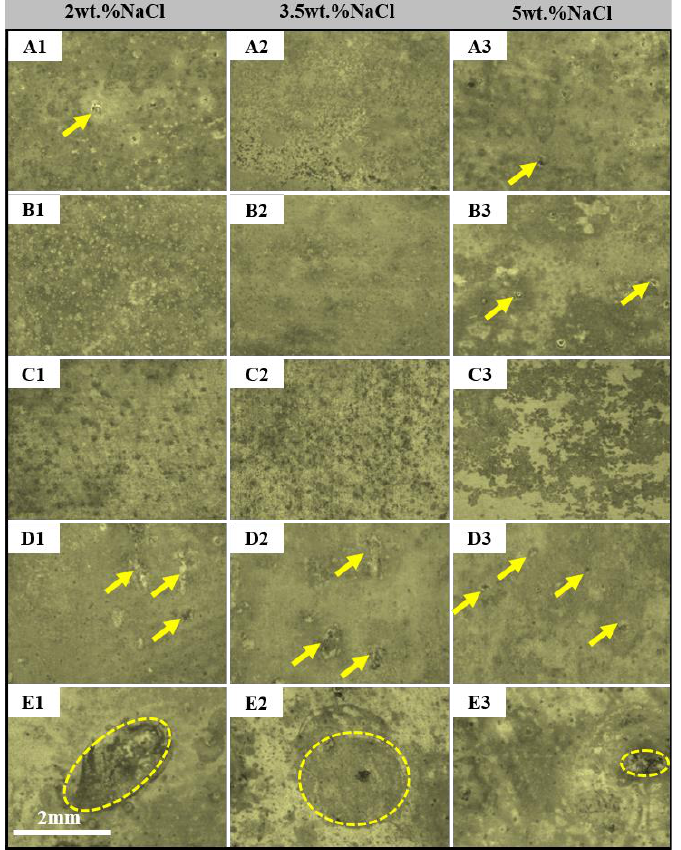
Figure 8. The macroscopic topography of specimens soaked in different concentrations of NaCl solution for 21 days ( A : 2A97-T3; B : 2A97-T6; C : 2024-T4; D : 2060-T8; E : 2099-T83).